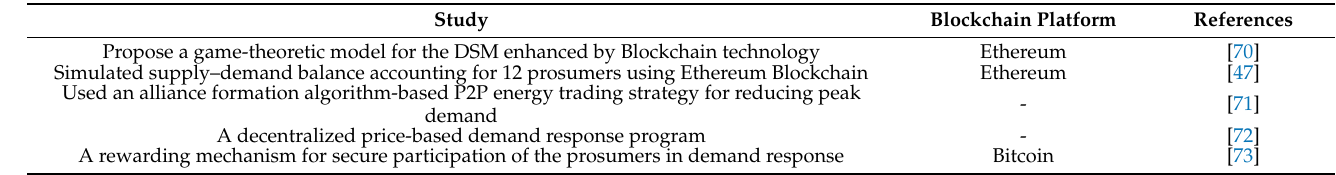
Table 6. Summary of publications employing Blockchain technology for